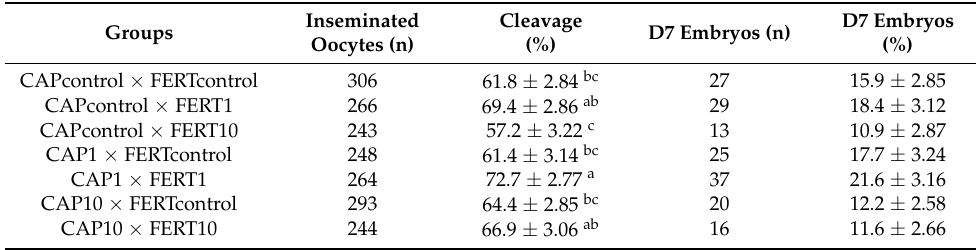
Table 3. Effect of oocytes and semen treatment with different concentrations of AntiOxBEN2 on cleavage and embryo production rates (mean ± SEM, 6 sessions).